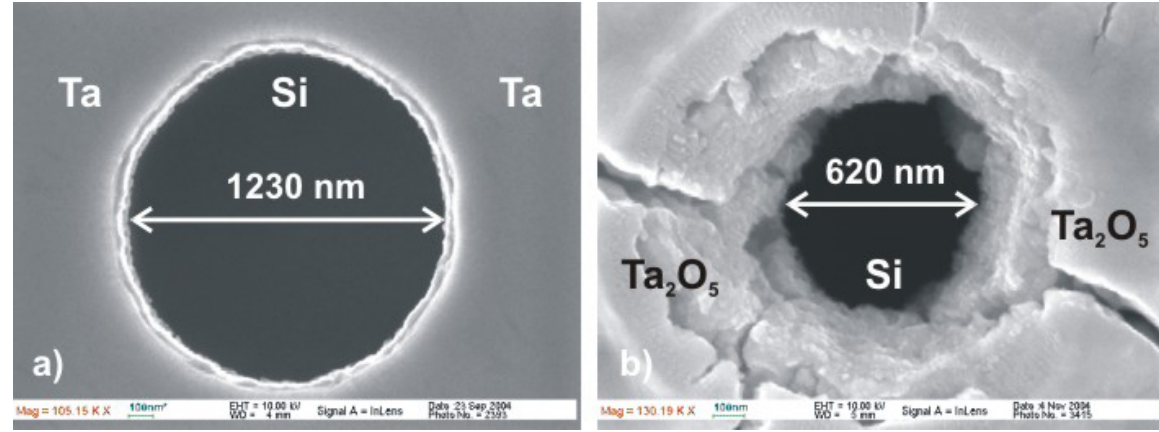
Figure 3. Scanning electron microscopy picture of a prepared circle-shaped structure before (a) and after (b) Ta oxidation. A pattern-size reduction of about 610 nm or by a factor of about 2 has been